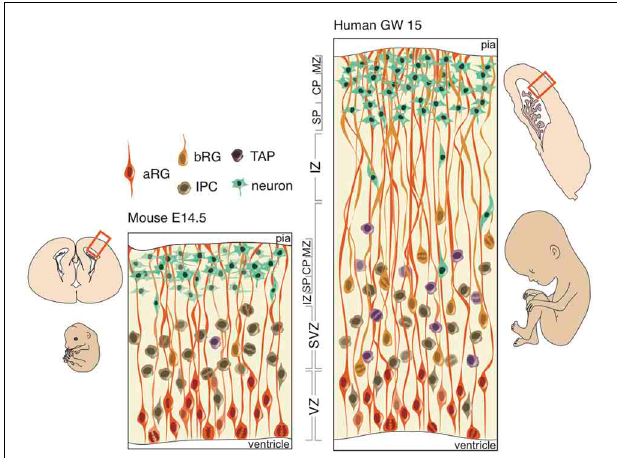
FIGURE 2 | Schematic of neural progenitors in the developing neocortex in mouse (left) and human (right). Polarized progenitors (bRG and aRG) are depicted with processes extending to the apical (bottom) and/or basal (top) surface. Non-polarized cells (IPCs and TAPs) divide exclusively in the SVZ in both mouse and human. The human SVZ is relatively expanded compared to the mouse and divided into an outer (OSVZ) and inner (ISVZ) region. CP, cortical plate; IZ, intermediate zone; MZ, marginal zone; SP,